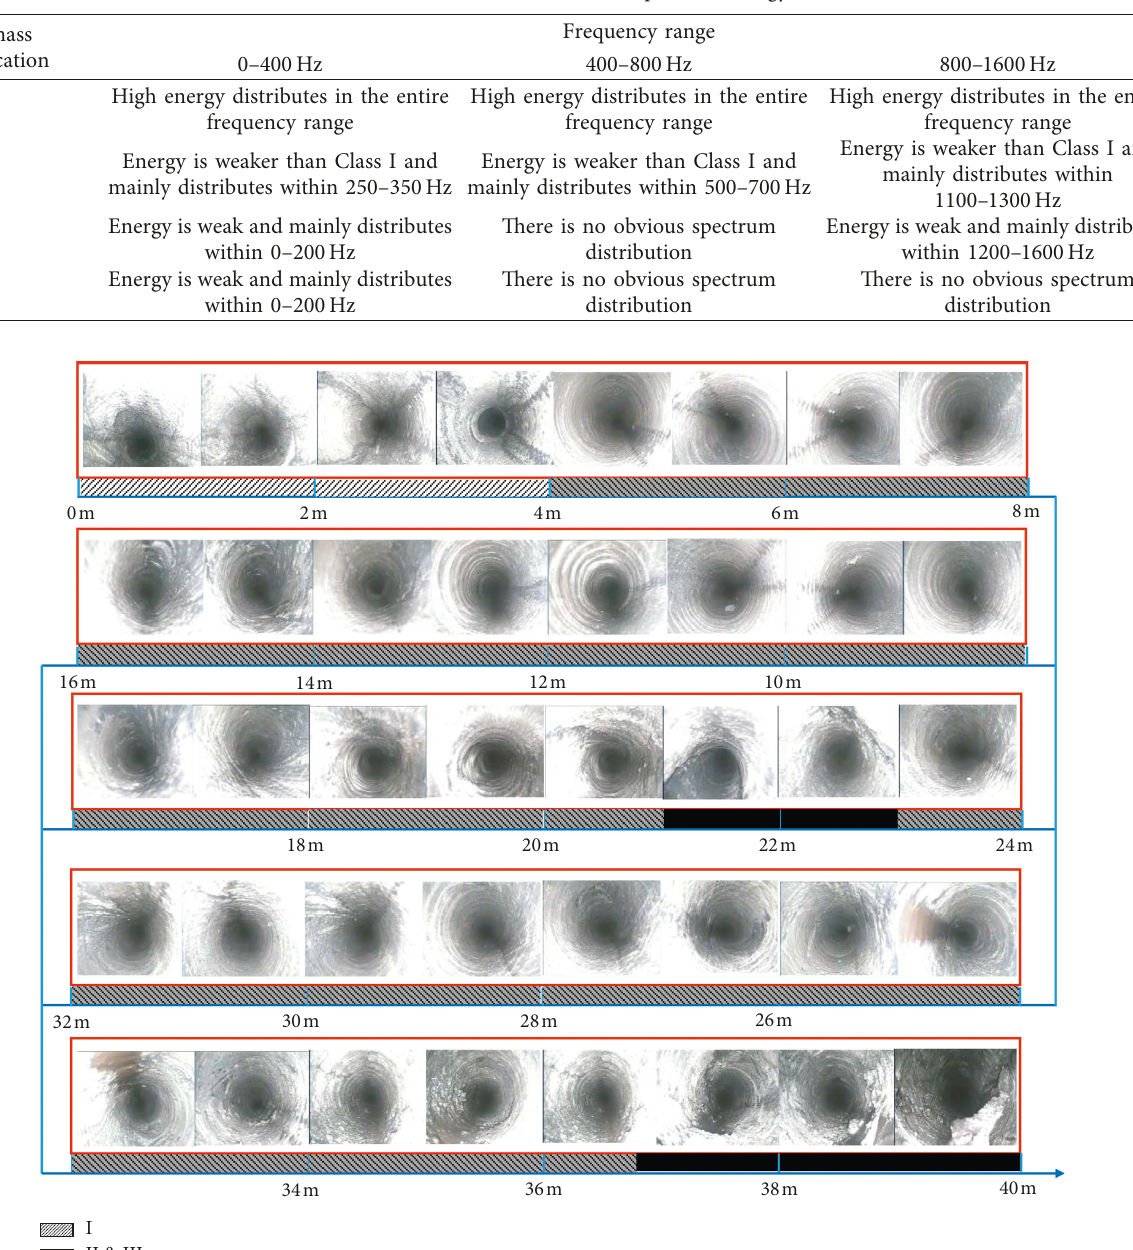
Figure 17: Spectrum distribution of the in-seam borehole No. 22. Table 4: Rock mass classification based on the spectrum energy distribution.